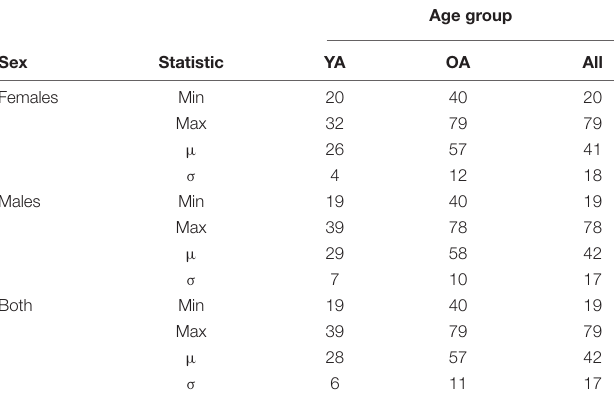
TABLE 1 | Participants’ ages in years (y) by sex and age group, i.e., YAs and